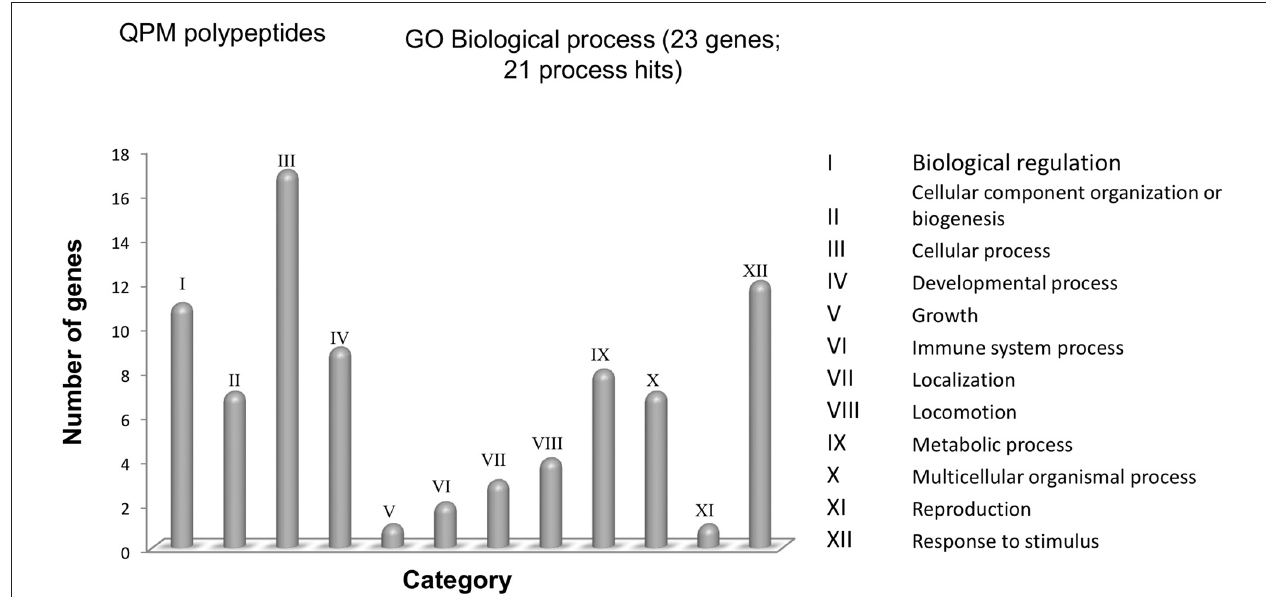
FIGURE 1 | Functional classification with PANTHER of the polypeptides found in exosomes. The UniProtKB IDs of proteins were submitted to the PANTHER database for their classification in Gene Ontology (GO) according to Biological. X -axis, categories of proteins. Y -axis, number of genes contained in each